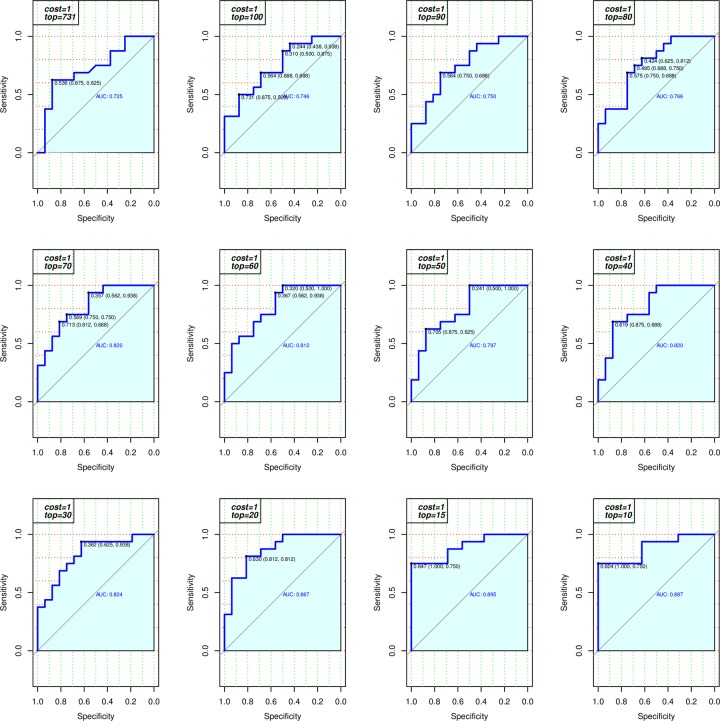
ROC from one of the training set.These ROC curves are obtained when fixing cost = 1 and iteratively decreasing top values from 731 to 10. In each ROC plot, the AUC value is calculated, and the corresponding sensitivity and specificity are marked.